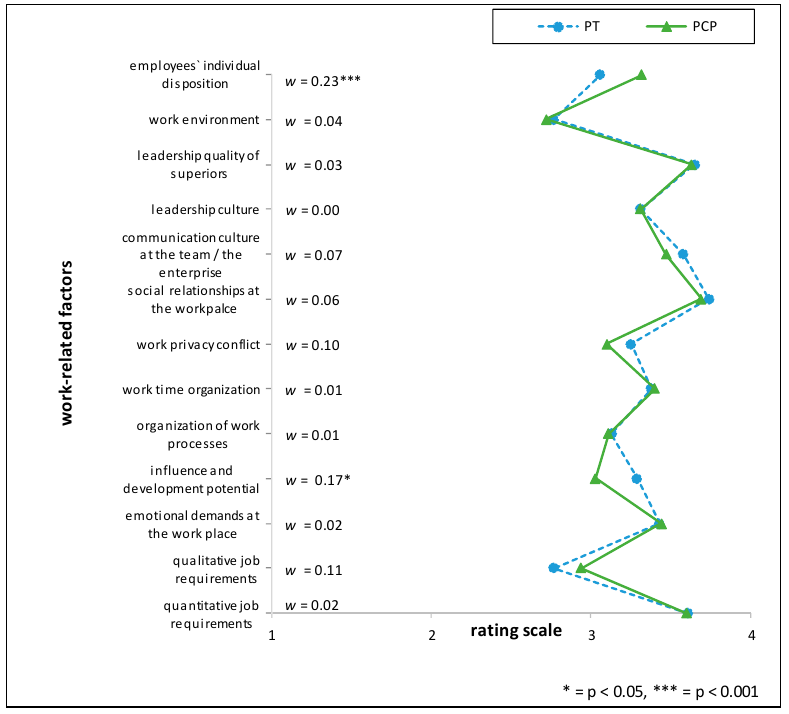
Figure 5. Polarity profile across work-related factors potentially important for (stress-associated) mental disorders in employees comparing the mean value ratings from “not at all important” (1) to “very important” (4) of Occupational Physicians (OP) and Psychotherapists (PT), w = effect size of differences.